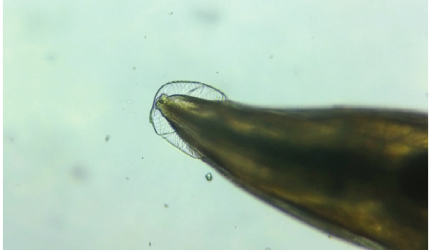
Figure 6: Cervical alae of Enterobius vermicularis , under low power.